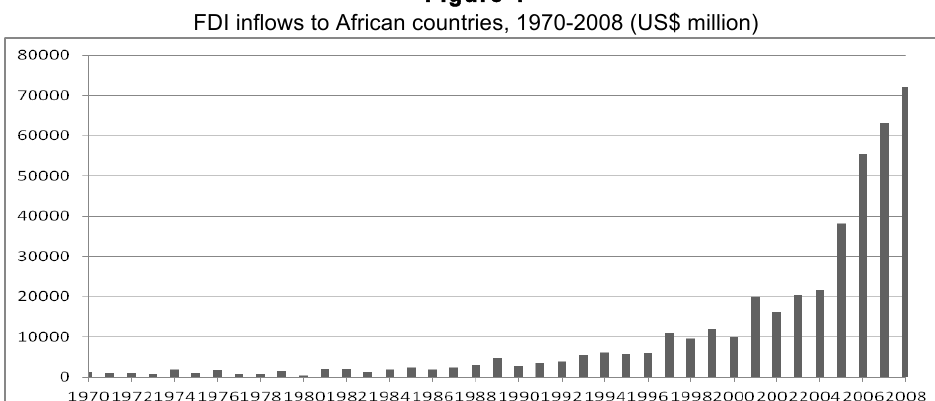
FDI inflows to African countries, 1970-2008 (US$